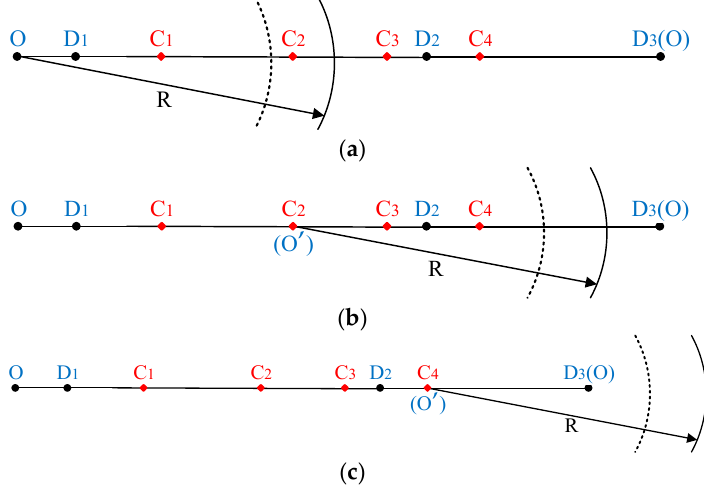
Figure 8. The feasibility analysis of the trip chain; ( a ) the first analysis; ( b ) the second analysis; ( c ) the third analysis.